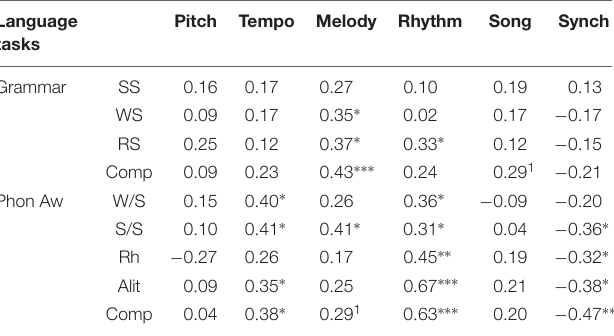
TABLE 2 | Participants’ performance in cognitive, linguistic, and musical tasks. Method of scoring